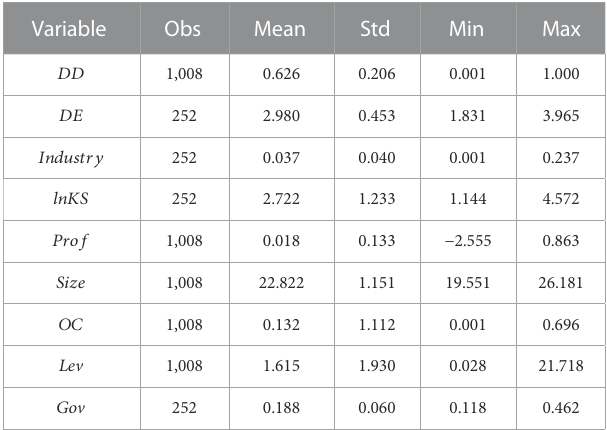
TABLE 3 Descriptive